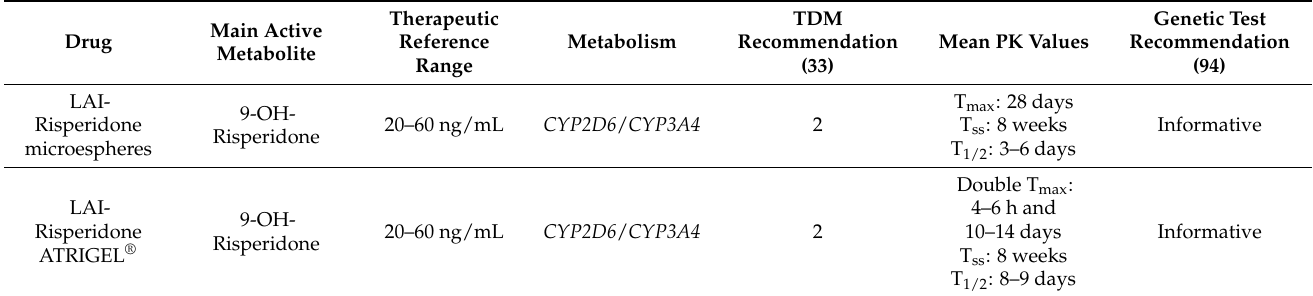
Table 2. Summary of PK/PG characteristics of